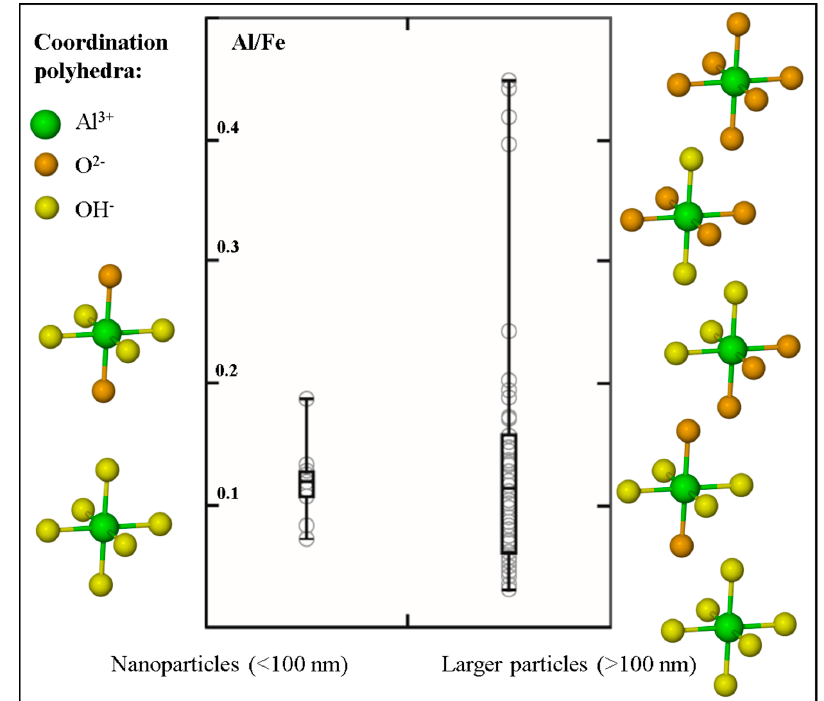
Figure 4. Box-and-whisker diagram comparing the Al / Fe ratio measured in nanoparticles versus the range measured in larger sub-micrometer ( > 100 nm) and micrometer sized particles (data extracted from [34]). Side panels show the diversity in the number of hydroxyl ligands coordinated to the Al metal centers in the two size fractions (from interpretations of Al K-edge XANES [34,52]; ligand positions are not absolute). These side panels highlight that hydroxyl ligands predominate over oxygen ligands in the Fe-rich nanoparticles, whereas larger-sized natural Fe particles are characterized by a prevalence of both oxygen and hydroxyl ligand bonding.